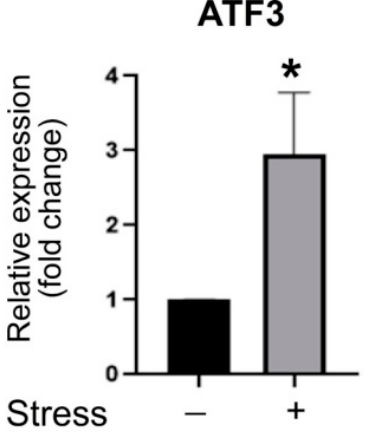
Figure 4. Relative duodenal mRNA expression levels of the ATF3 gene in WT mice. Through qRT-PCR analysis, the relative mRNA expression levels of the ATF gene of the mouse duodenum with or without 9 h of restraint stress. The mRNA expression levels of the control (no stress; stress − ) groups were normalized to 1-fold. Error bars show the standard deviation. n = 3 (2 experiments with a total of 3 mice per group). * p < 0.05 vs. no stress control groups. The “stress − “ indicates no stress control groups and the “stress +” indicates the stressed groups.